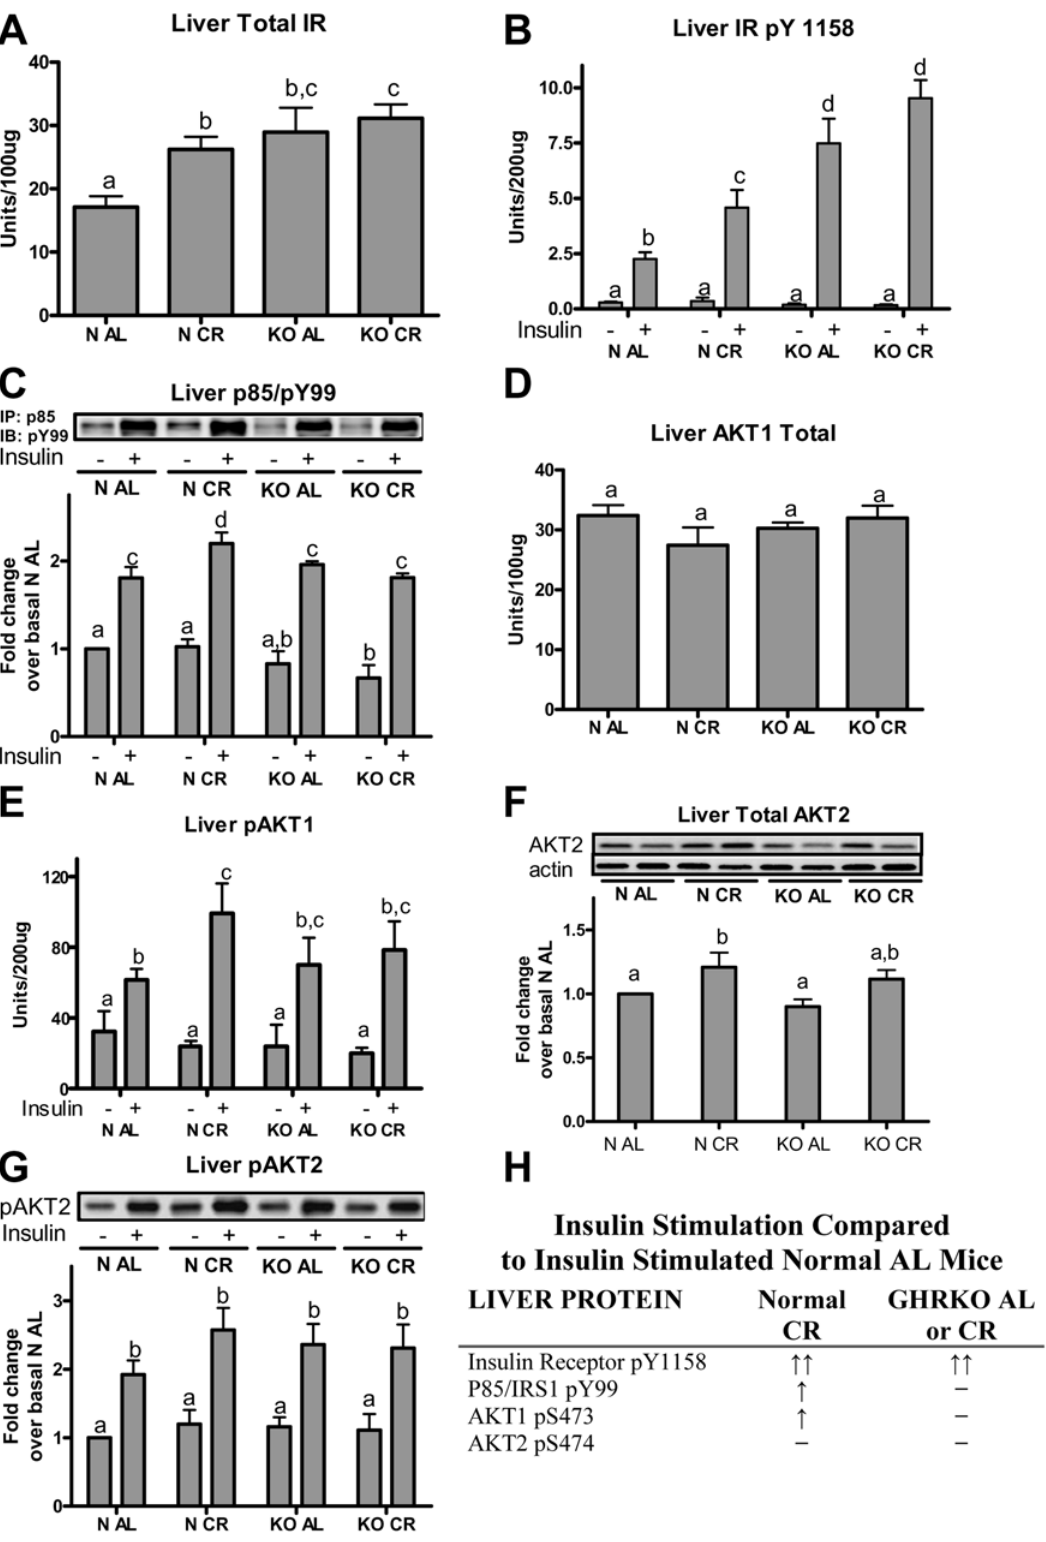
Figure 2. Liver insulin signaling cascade total proteins and phospho-proteins in response to insulin stimulation (10 IU/kg) versus saline treated controls in GHRKO (KO) and normal (N) mice fed adlibitum (AL) or 30% calorie restricted (CR) for one year. ELISA with antibodies directed towards total insulin receptor (IR; A), IR pY1158 (B), AKT1 (D), and AKT1 pS473 (E) were performed. Liver homogenates were immunoprecipitated (IP) with anti-p85, separated using SDS-PAGE and the level of non-specific Tyr phosphorylation was determined at approximately 180 kDa using anti-pY99 (C). Total AKT2 protein (F) and AKT2 pS473/474 (G) was determined from liver protein homogenates first